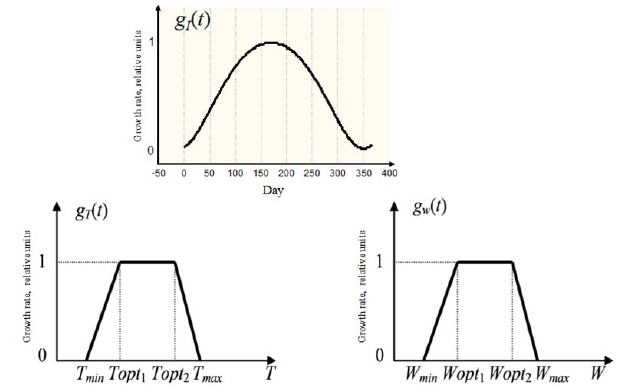
Fig. 1. Harmonic function that defines partial growth rate g I (t) depending on day length and piece-wise linear functions that define partial growth rates ( g T (t) and g W (t)) depending on temperature T and soil moisture W